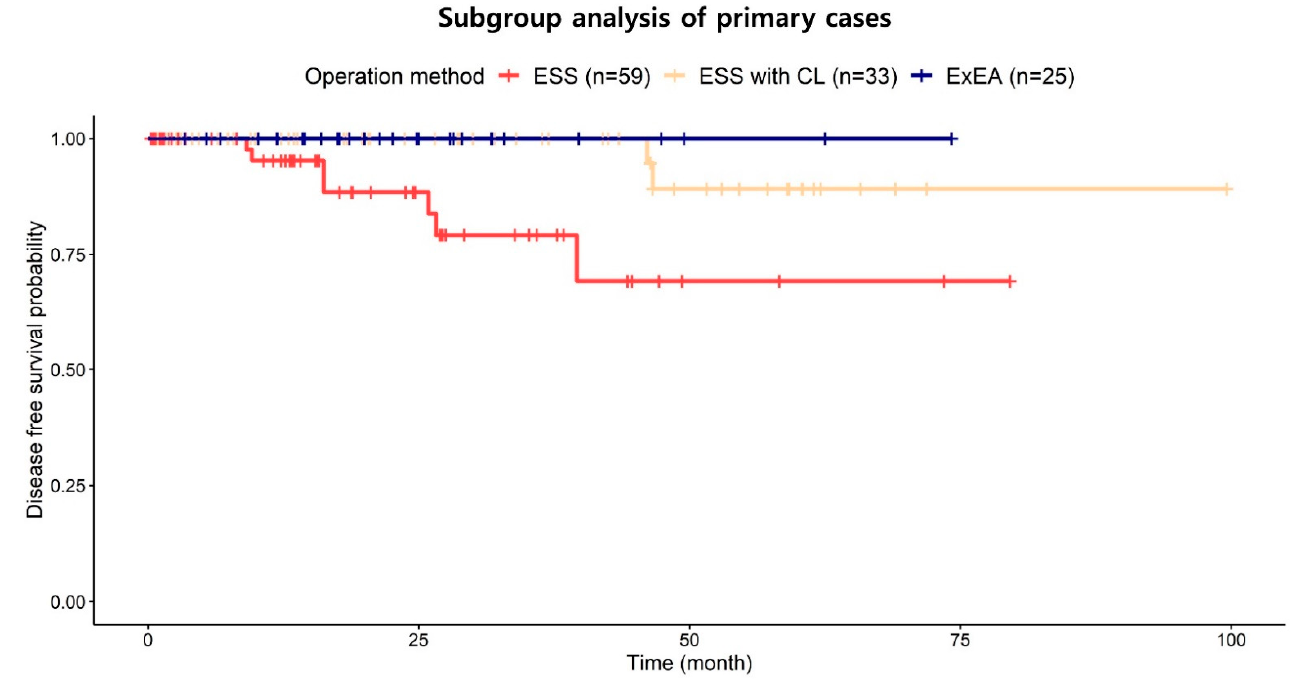
Figure 4. Kaplan–Meier plot for primary and revision cases. There were seven and two recurrences in primary and revision cases, respectively. There was no significant difference in recurrence rates between the two groups ( p = 0.600, log-rank test).